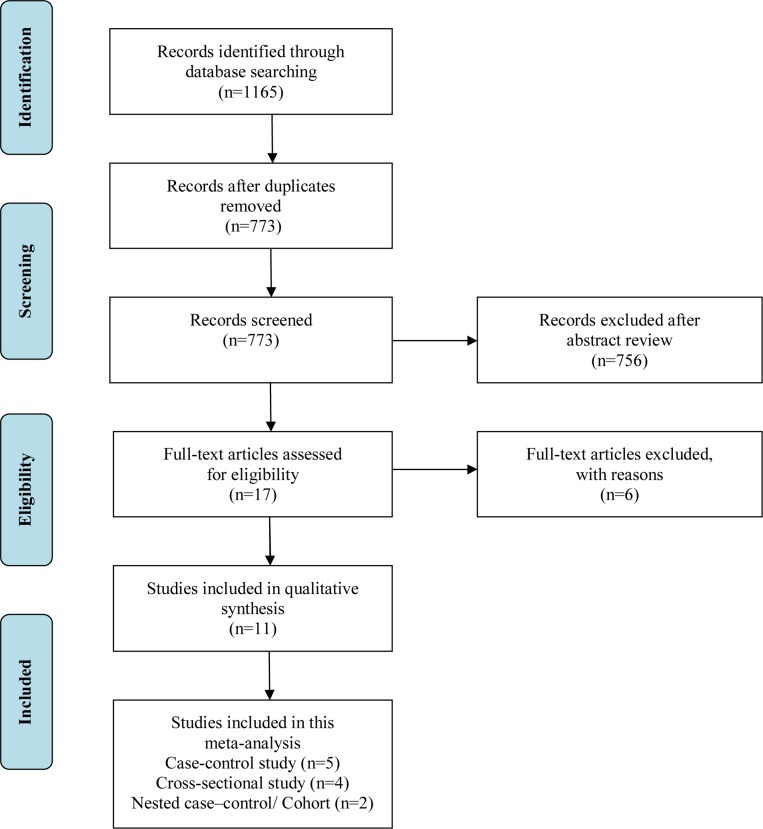
Flow diagram outlining the selection process for the inclusion of the studies in the systematic review and meta-analysis.